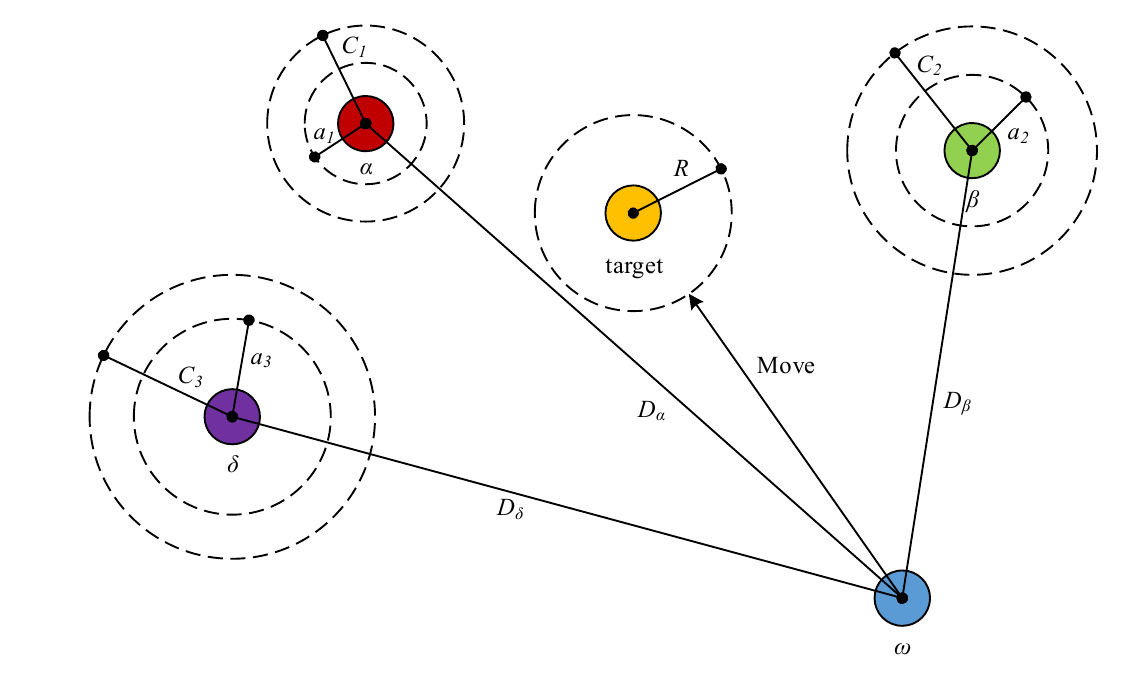
Figure 1. Position updating mechanism of GWO.